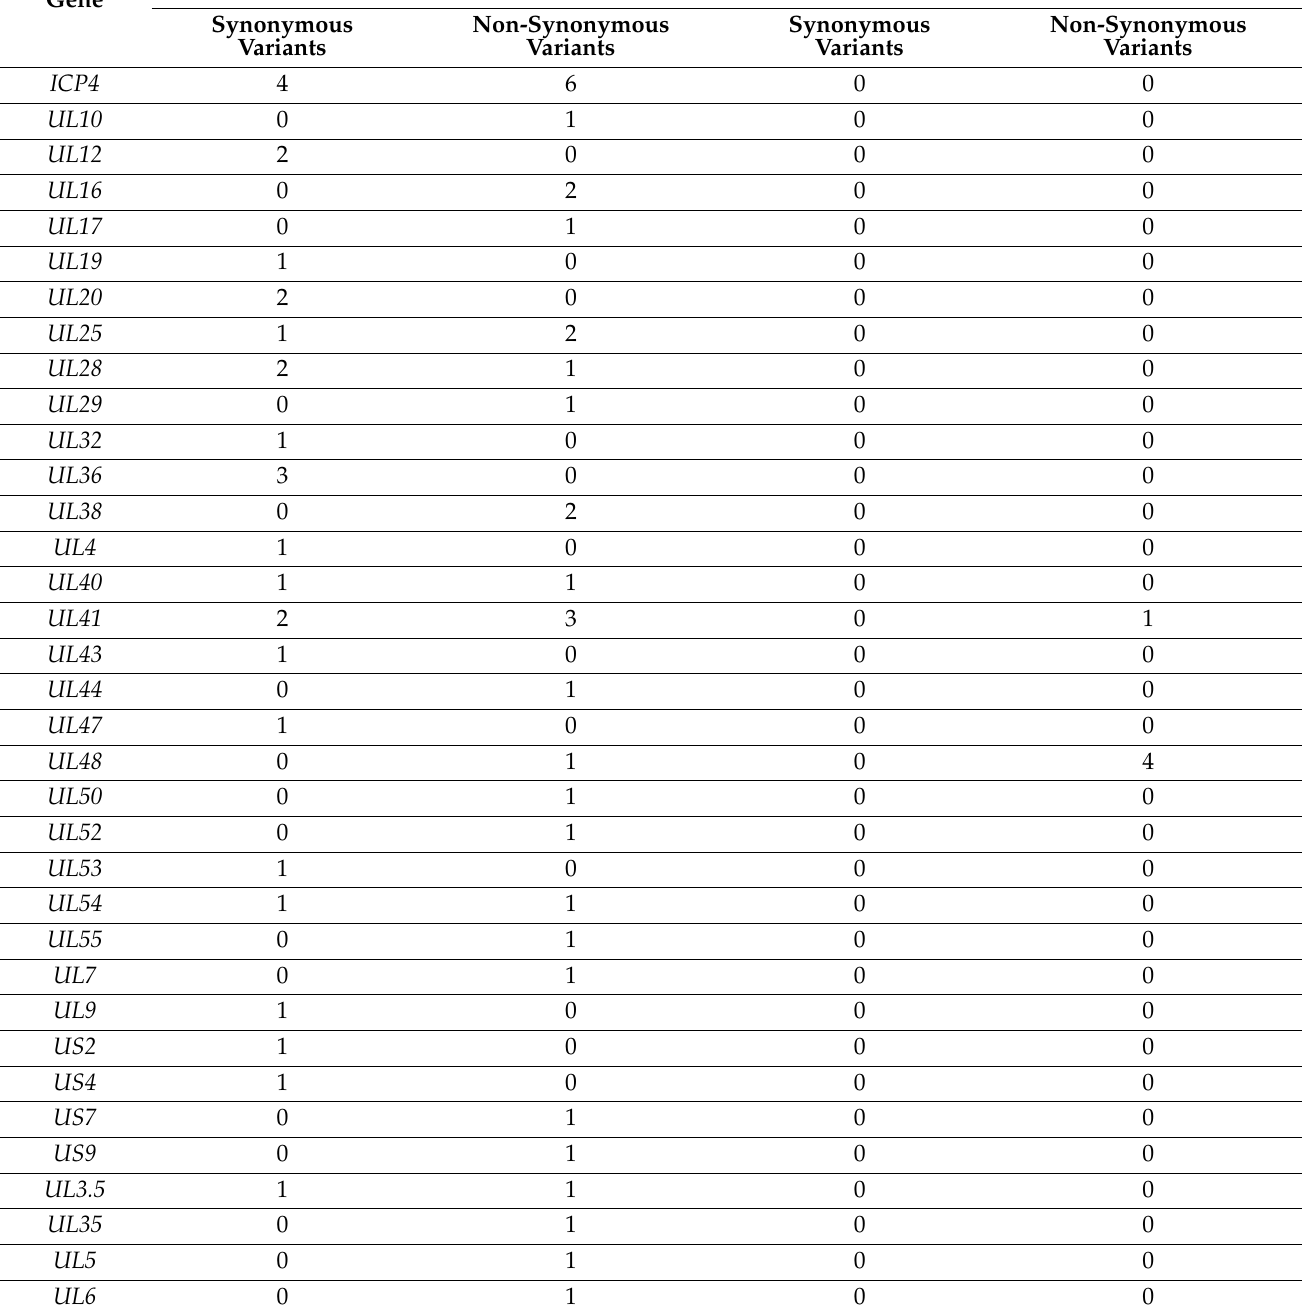
Table 3. Variants detected among feline herpesvirus type 1 (FHV-1) strains isolated from 10 captive cheetahs, a reference FHV-1 strain (C-27), and the viral strain in the Merial modified live vaccine (MLV). Note the infrequent detection of unique synonymous (0) and non-synonymous variants (5) between the MLV strain and isolates from vaccinated cheetahs. Variants were identified using Geneious Prime ver